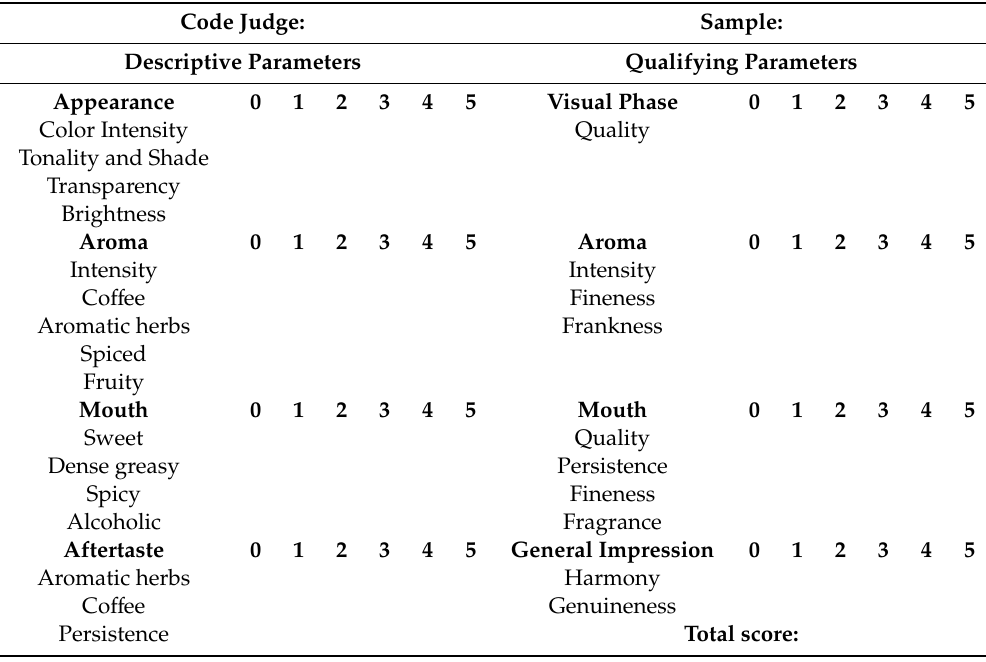
Table 2. The final taste test evaluation form used in the sensory analysis of the herbal spirits, herbal liquors, and co ff ee liqueurs.